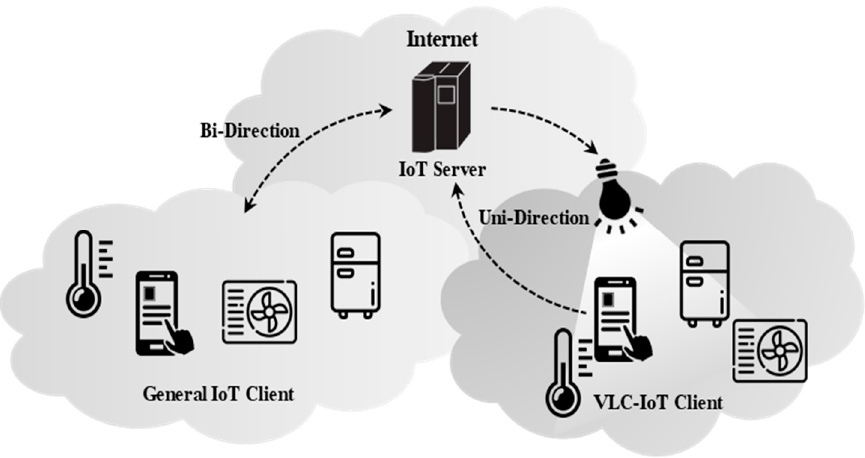
Figure 1. Network model for IoT services over unidirectional VLC networks.